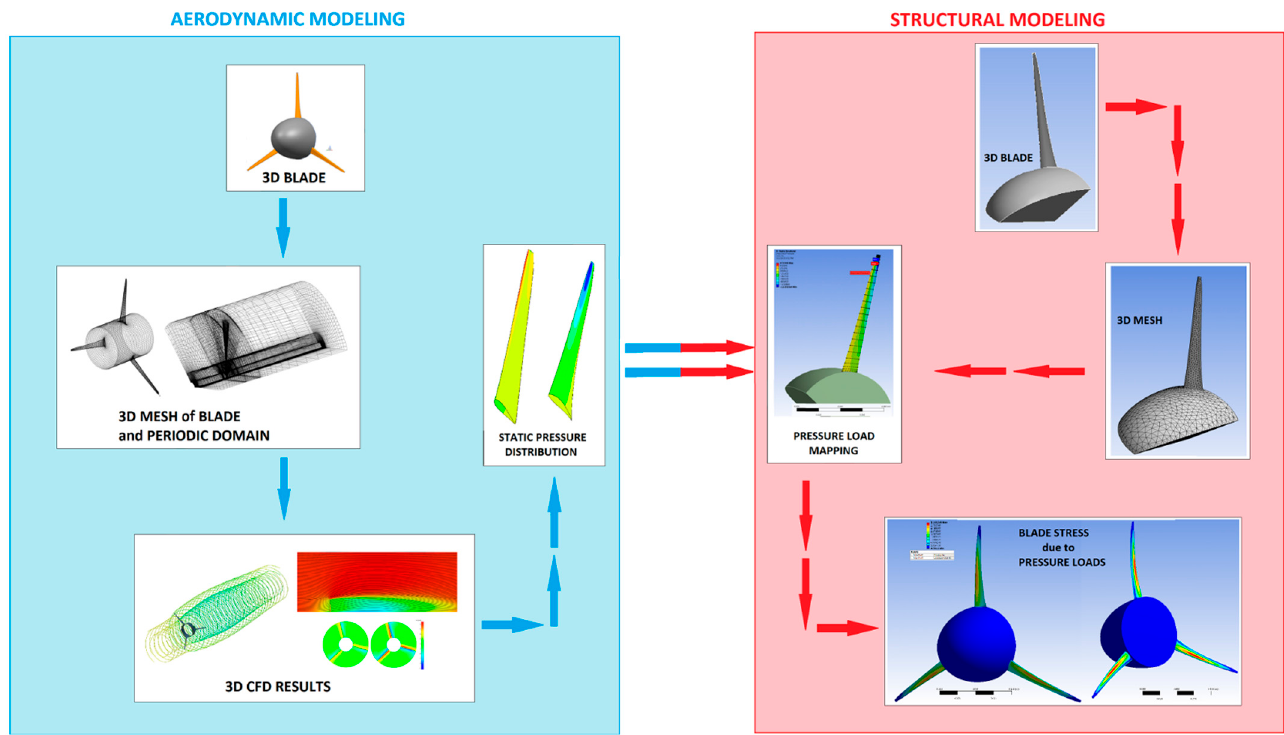
Figure 10. One-way fluid–structure interaction process using 3D CAD, 3DCFD and 3D FEA.